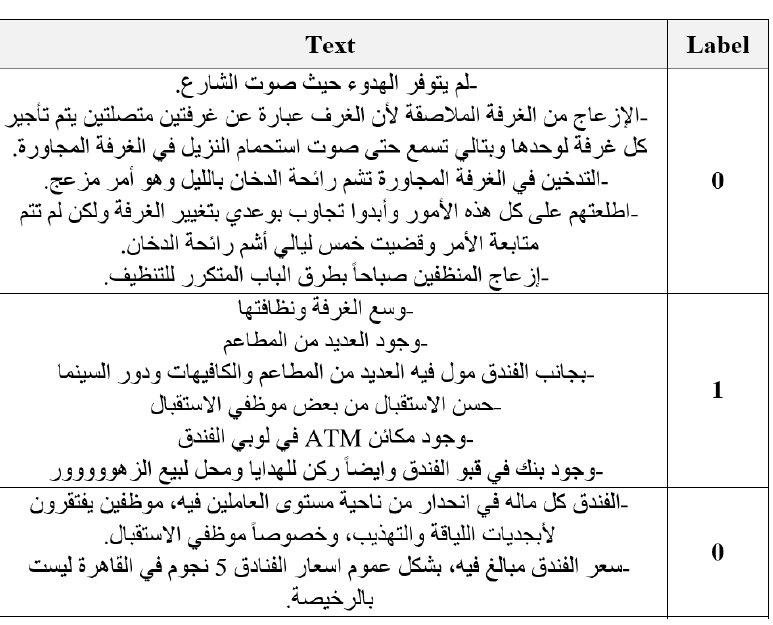
Figure 3. Sample records of our constructed dataset